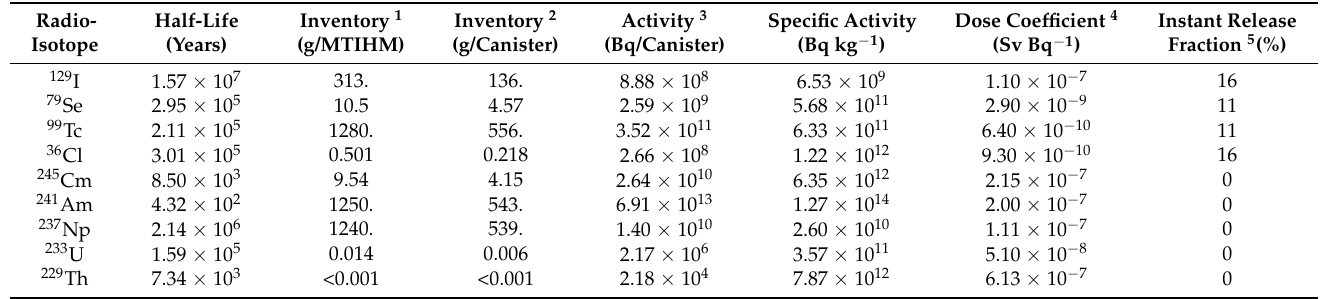
Table 1. Initial inventory, specific activity, dose coefficient and instant release fraction of selected radionuclides. Radio-